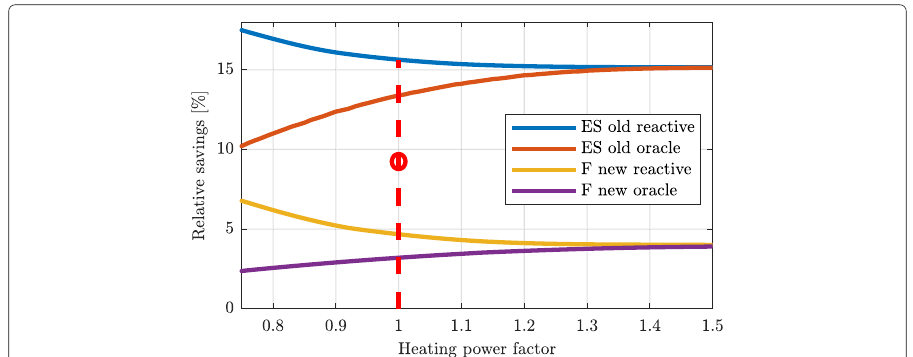
Fig. 9 The relative savings for two types of artificial households (typical schedules for employed singles (ES) and family (F), either in a “new” or “old” dwelling) depending on the design heat load (scaled default value). The vertical dashed line corresponds to the default design heat load, at which we carried out the main evaluation. The red circle marks the average (9.24% according to Table 3) of all households in the CER dataset using the oracle